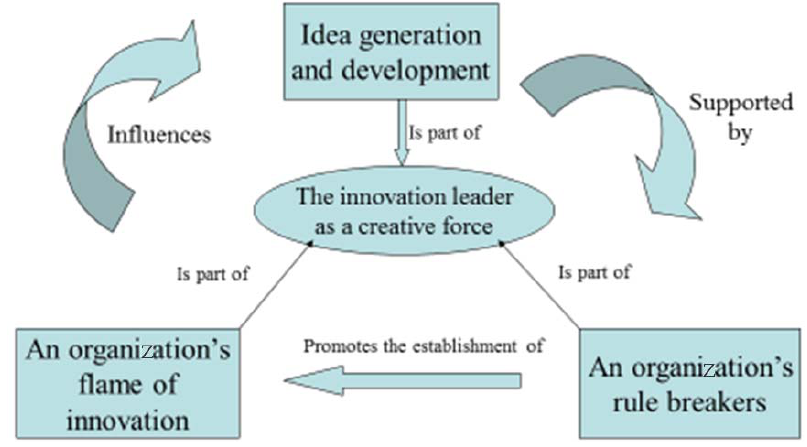
Fig. 5. The innovation leader as a creative